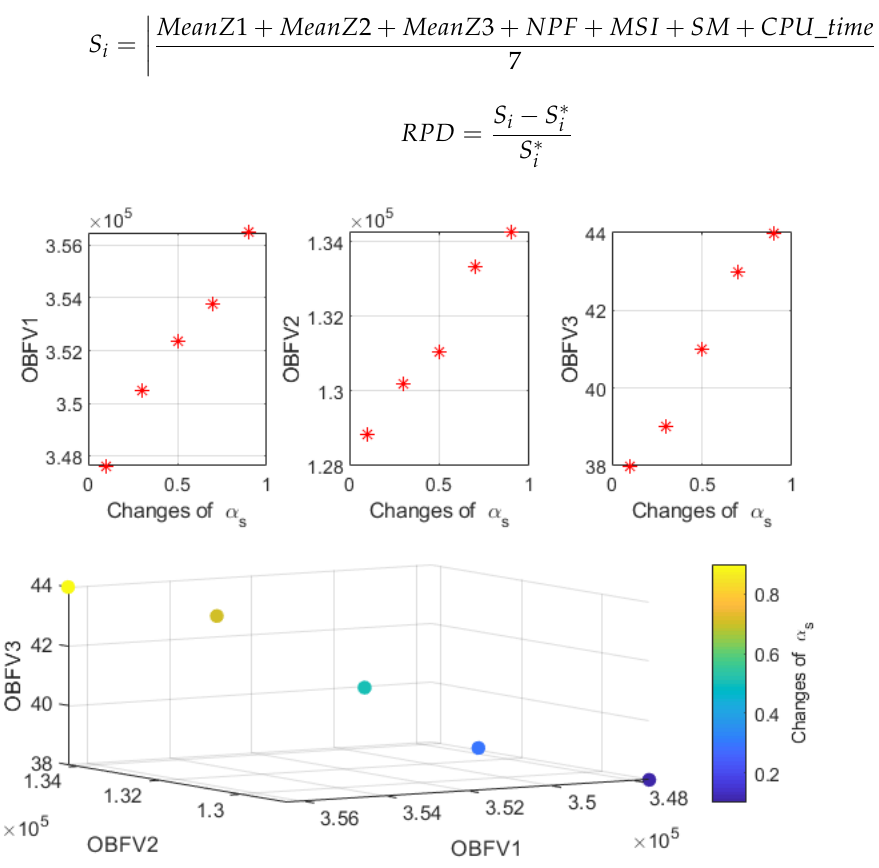
Figure 8. Trend of changes in the OBFVs in different value of parameter α s . Table 10. Proposed parameter levels for tuning of NSGA II and